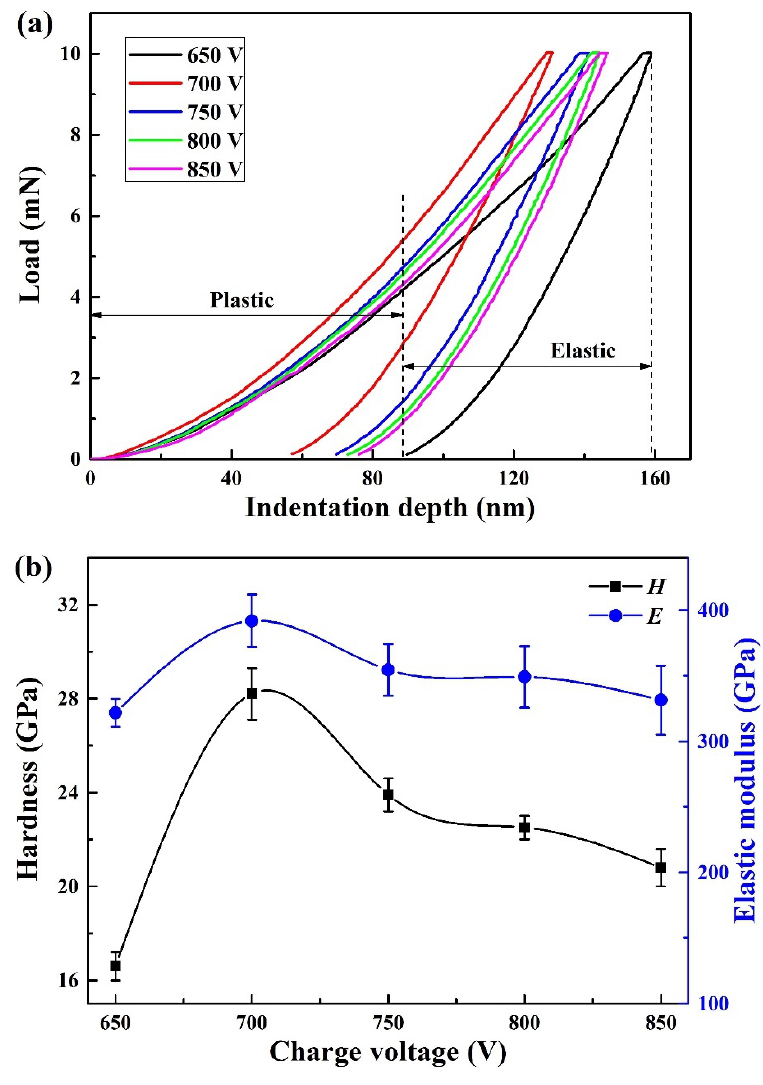
Figure 7. Typical indentation load–displacement curves ( a ), hardness and elastic modulus ( b ) of the coatings at various charge voltages.